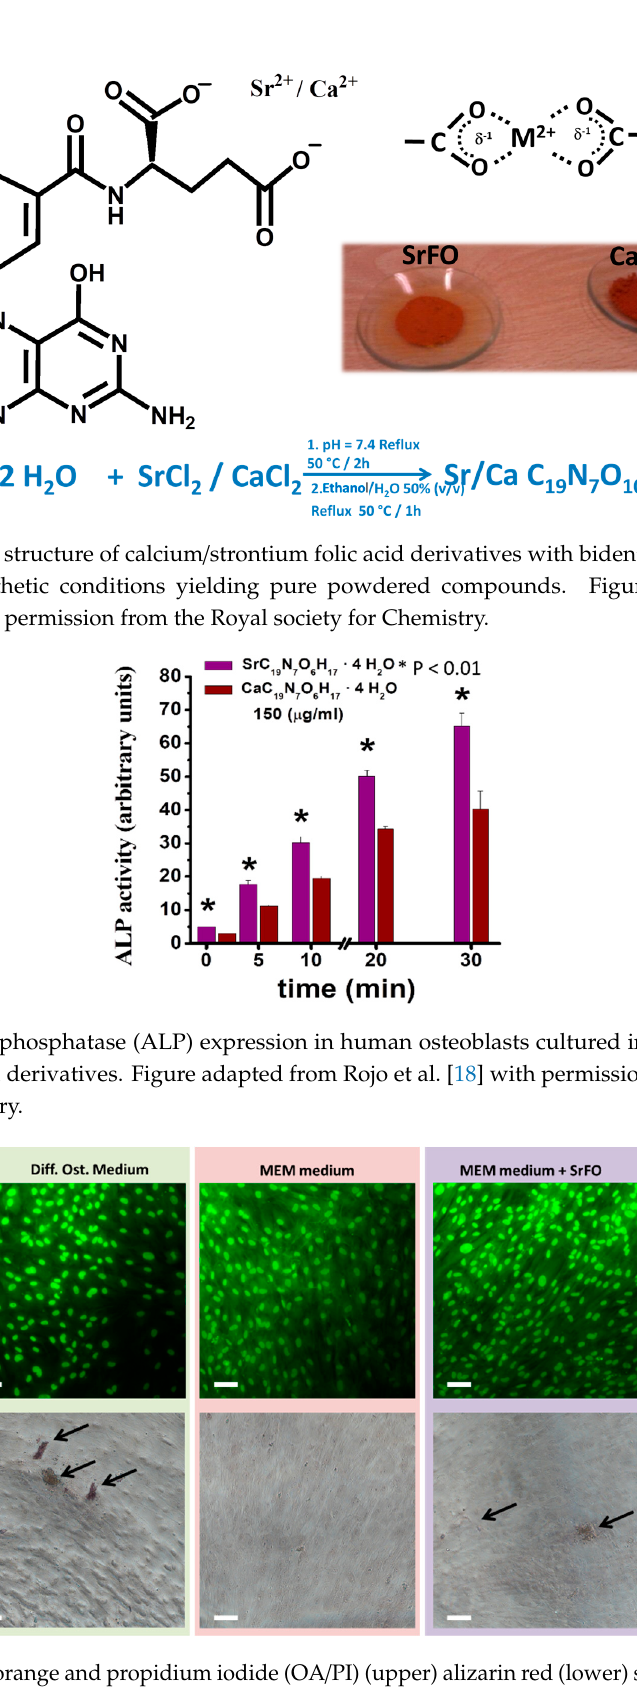
Figure 4. Acridine orange and propidium iodide (OA/PI) (upper) alizarin red (lower) staining of HMSC cultured for four days in osteogenic differentiation medium (left), MEM medium (center) and MEM + Strontium Folate (SrFO) (left). Arrows indicate deposits of calcified extracellular matrix. Scale bar = 100 µm [105].